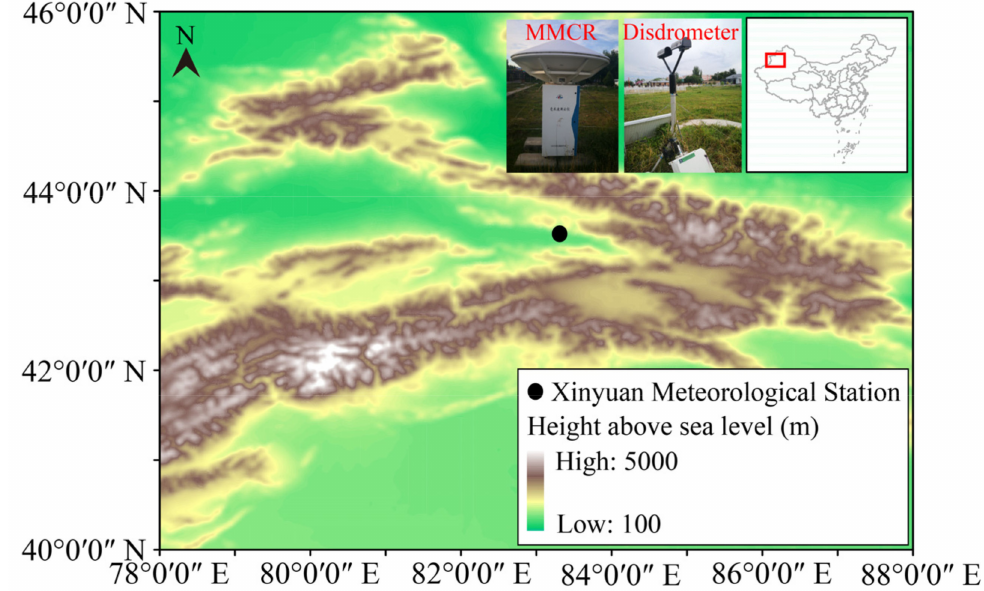
Figure 1. Location of the Xinyuan Meteorological Station (XY, 83.25 ◦ E, 43.45 ◦ N, 929.7 m above sea level) and the photos of the millimeter-wave cloud radar (MMCR) and disdrometer at the Xinyuan Meteorological